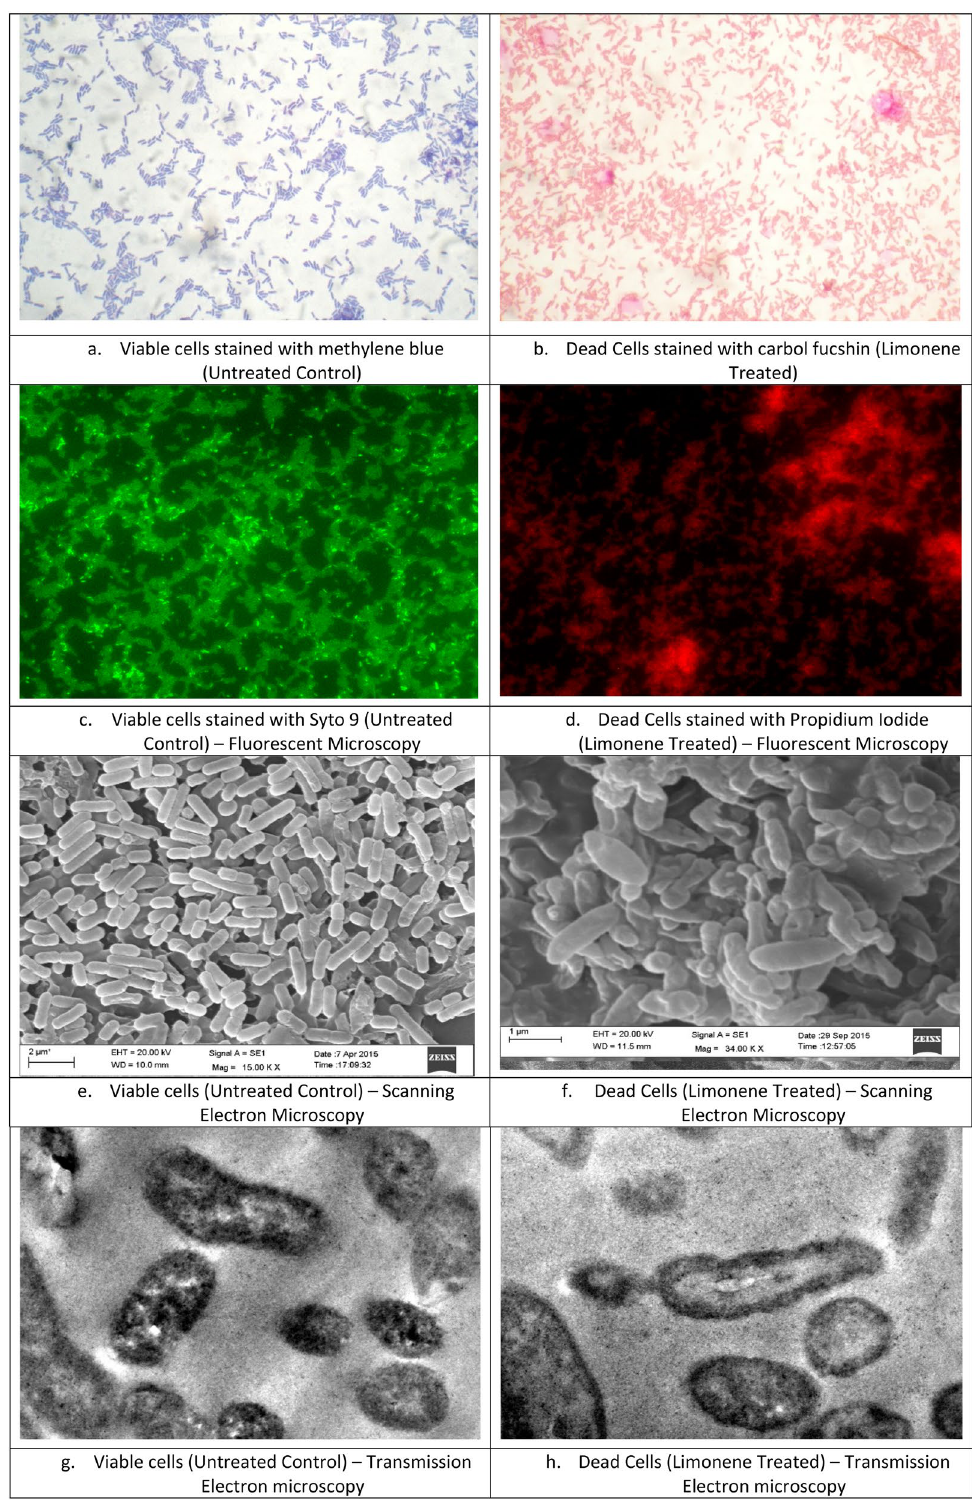
Figure 9. Micrographs of untreated control and limonene treated (1XMIC) E. coli cells using Compound microscopy ( a , b ) fluorescent microscopy ( c , d ) Scanning electron microscopy ( e , f ) Transmission Electron Microscopy ( g , h